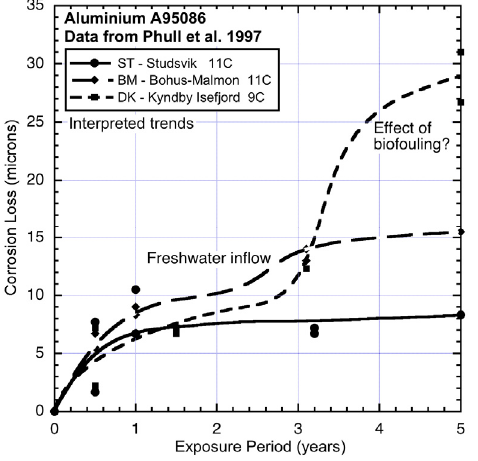
Figure 9. Corrosion loss data and trends for aluminium (type A95086) at DK, BM and ST showing effects of salinity and of gross biofouling. Data from [1].